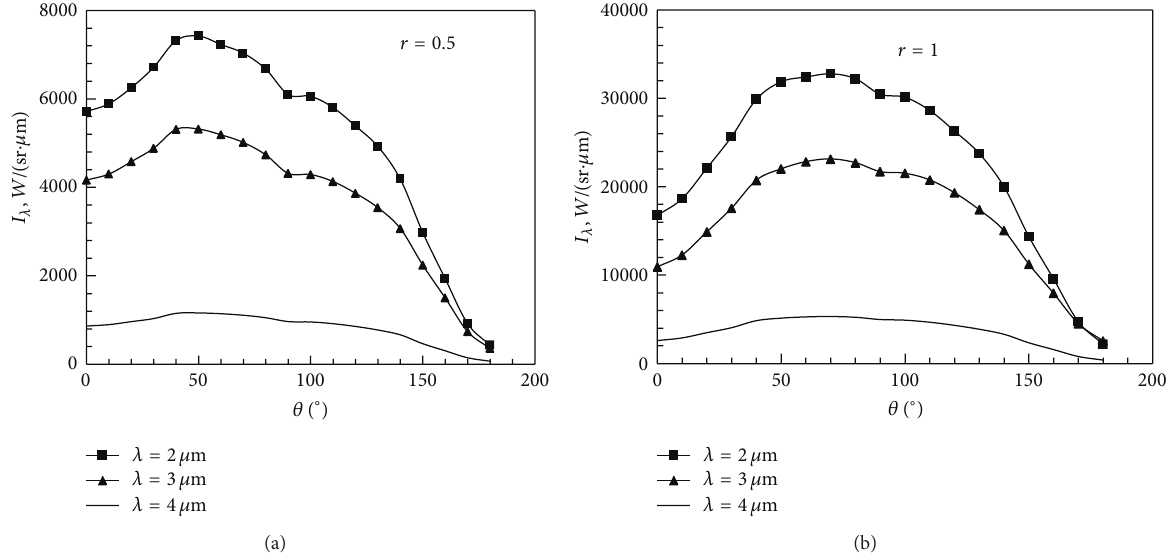
Figure 11: Variation of radiation intensity of plume with zenith